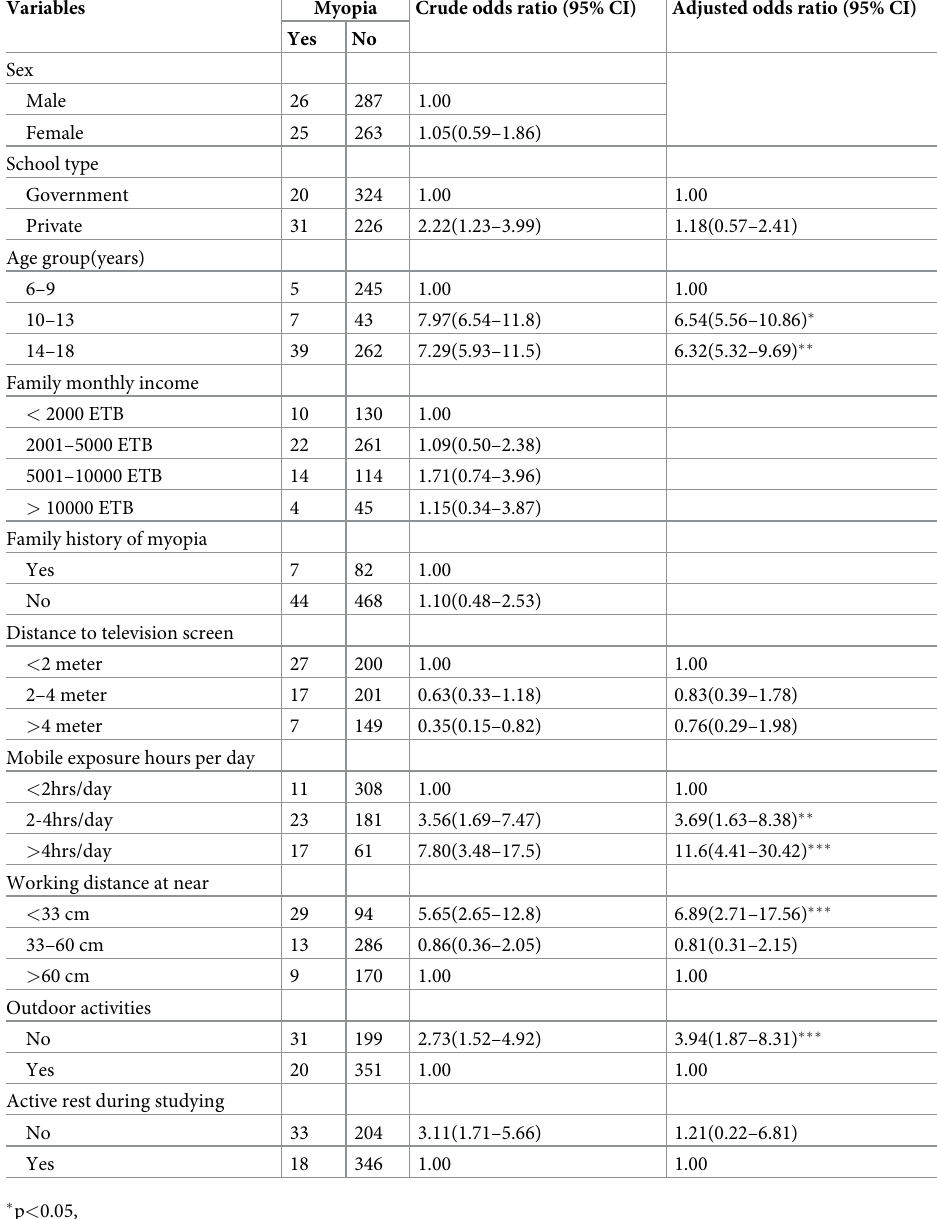
Table 3. Factors associated with myopia among school children, Bahir Dar city, Northwest Ethiopia, 2019 (n = 601).